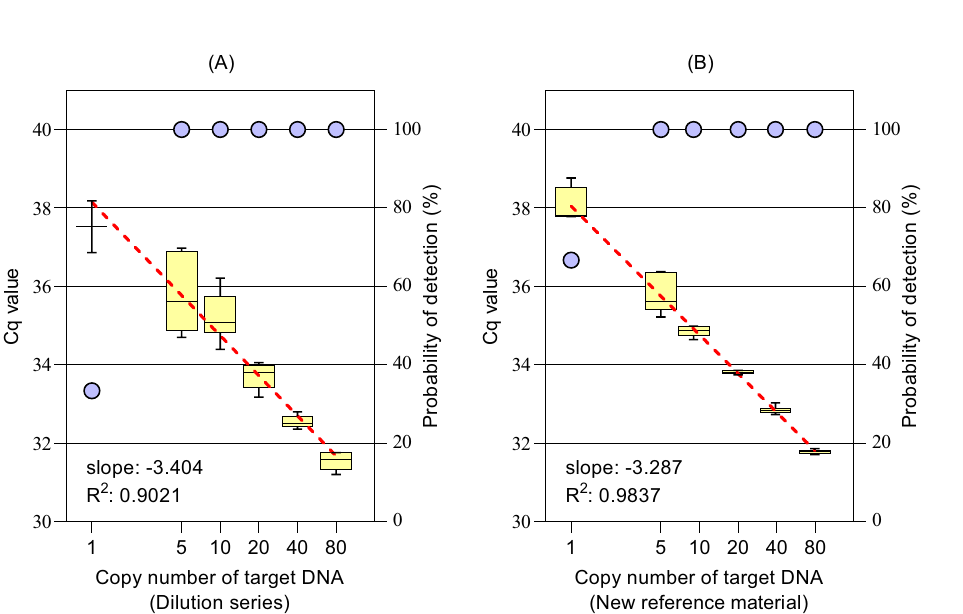
Figure 1. Box plots of real-time PCR results and standard curves (red dashed lines) for ( A ) calibrator prepared by the serial dilution method and ( B ) calibrator prepared using the new reference material. A whisker in the box plots shows the 10th and 90th percentiles. A purple circle indicates the percentage of wells in which the calibrator of each copy number amplified (probability of